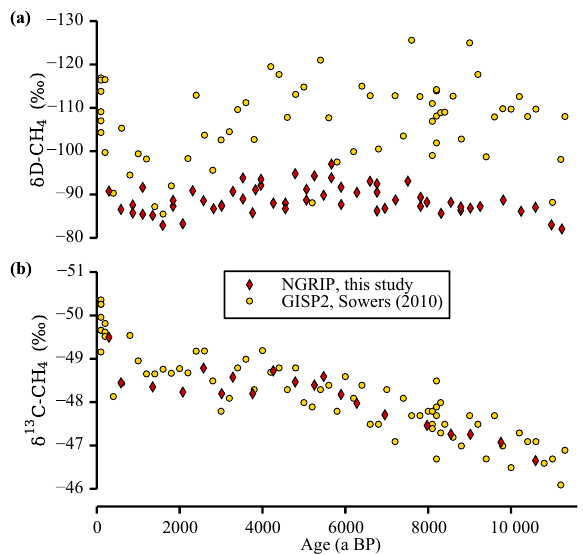
Figure 4. Comparison of stable CH 4 isotope data. This study’s stable CH 4 isotope values of the NGRIP ice cores are shown to- gether with the data published by Sowers (2010) using the GISP2 ice core. The δ D-CH 4 data sets (a) differ in the absolute level and the variance, whereas the δ 13 C-CH 4 data (b) are in good agree- ment. Note that all data are corrected for gravitational fractionation in the firn column. All data of this study are free of krypton interfer- ence, whereas the GISP2 δ 13 C-CH 4 record has been subsequently corrected for it (Schmitt et al., 2013). Note the inverted y